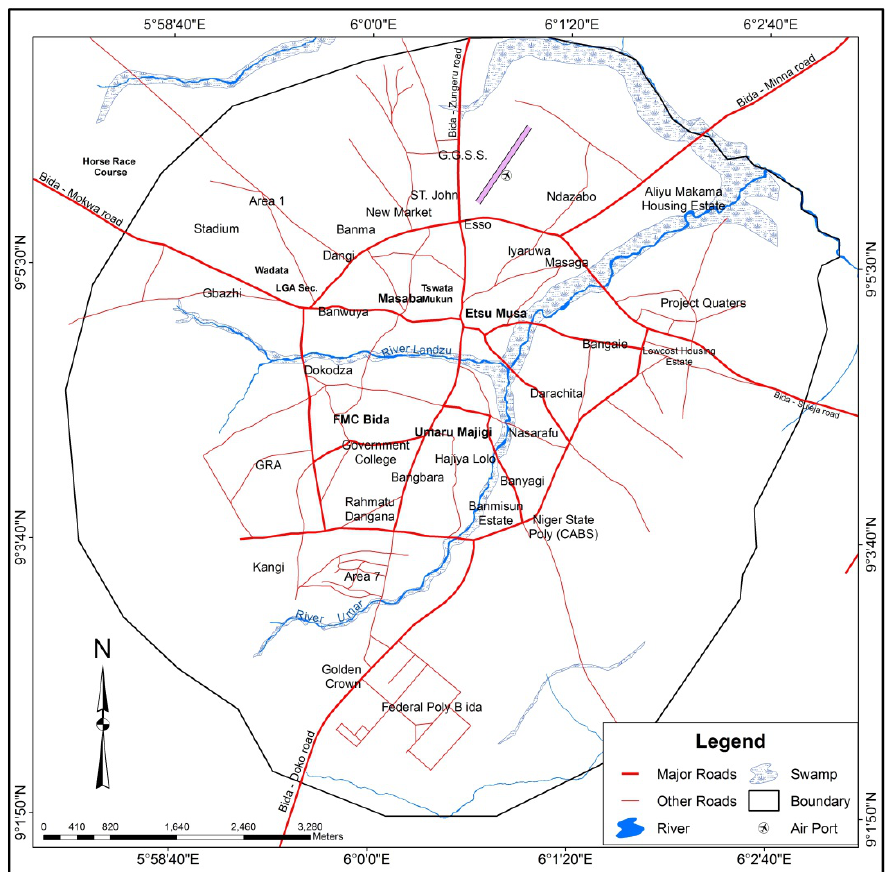
Fig. 1. Map of Bida (Field survey,